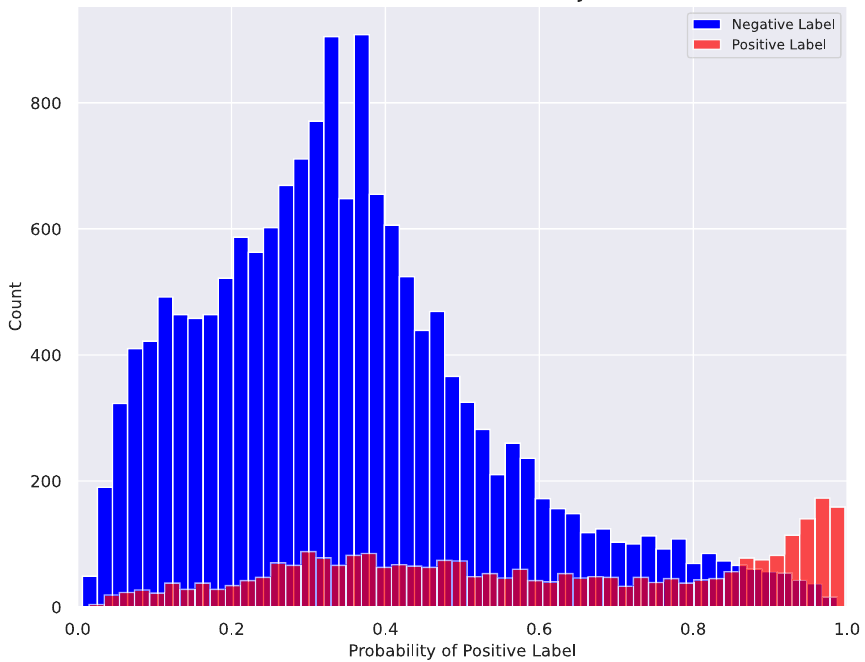
Figure 3. Distribution of predicted class probabilities derived from the multi-tree XGBoost model. Blue bars represent patients who tested RT-PCR negative, and red bars represent patients who tested RT-PCR